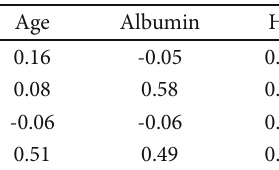
Figure 2: Correlation of IGRA: IFN release and TST measured in mm. Table 4: Pearson ’ s correlation of TST and IGRA.